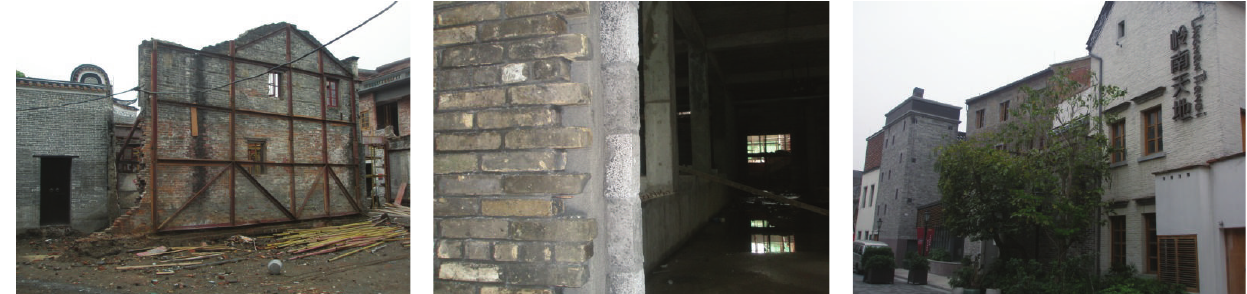
Figure 17: Lingnan Tiandi: conservation and reinforcement; material recycling; culture, taste, and